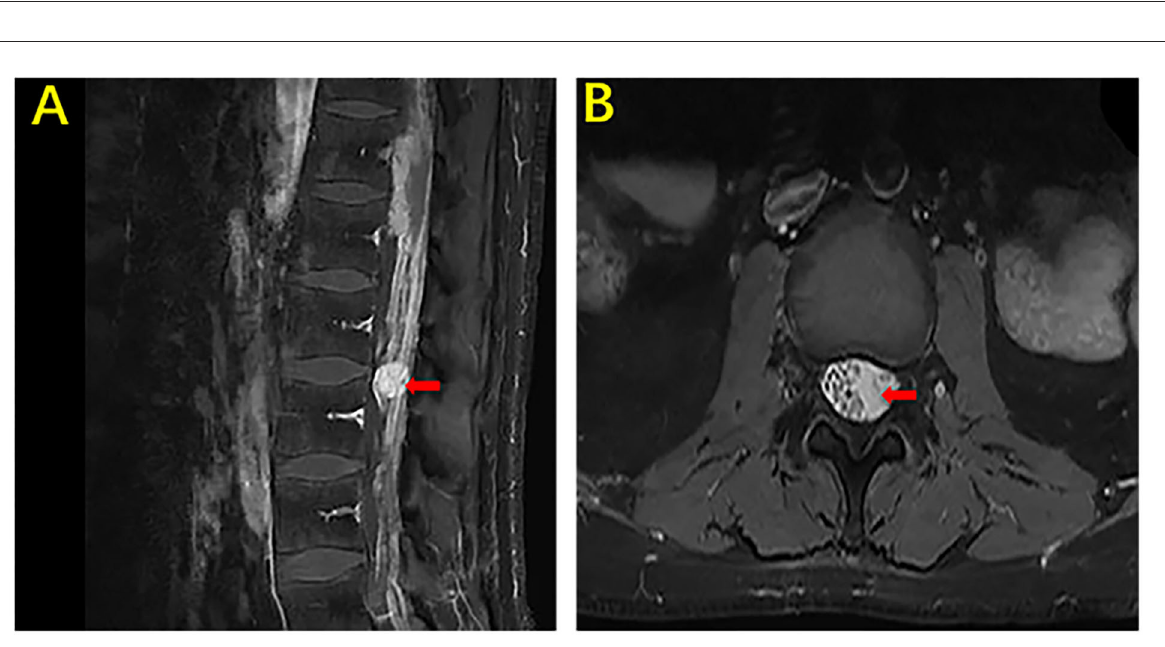
lowest prevalence of NTM infections was 8.6%